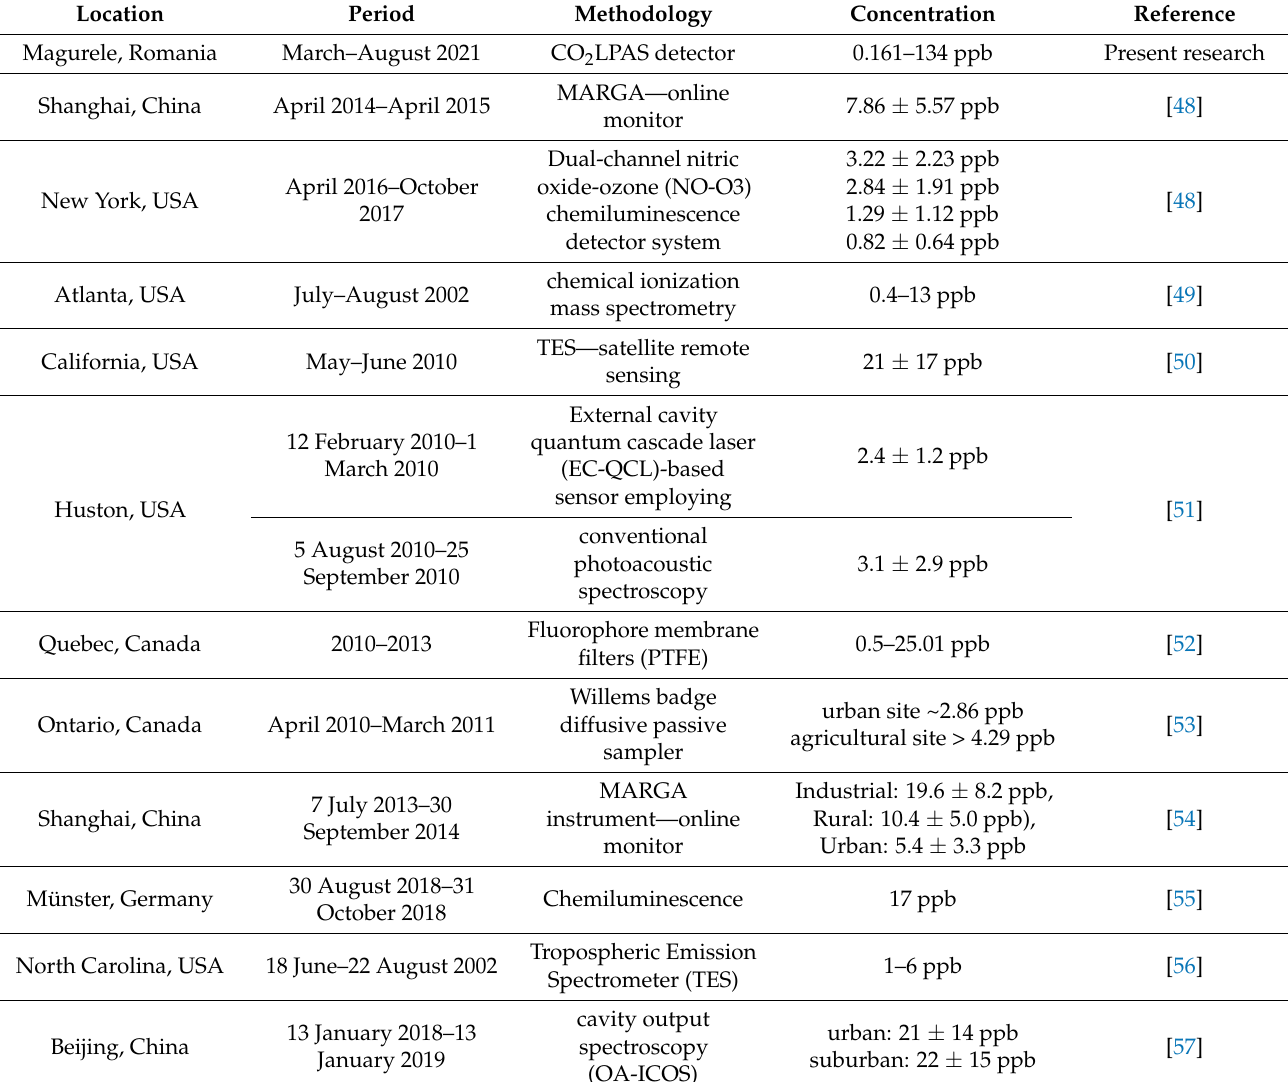
Table 1. Ambient NH 3 concentration measurements in the urban atmosphere in different coun-